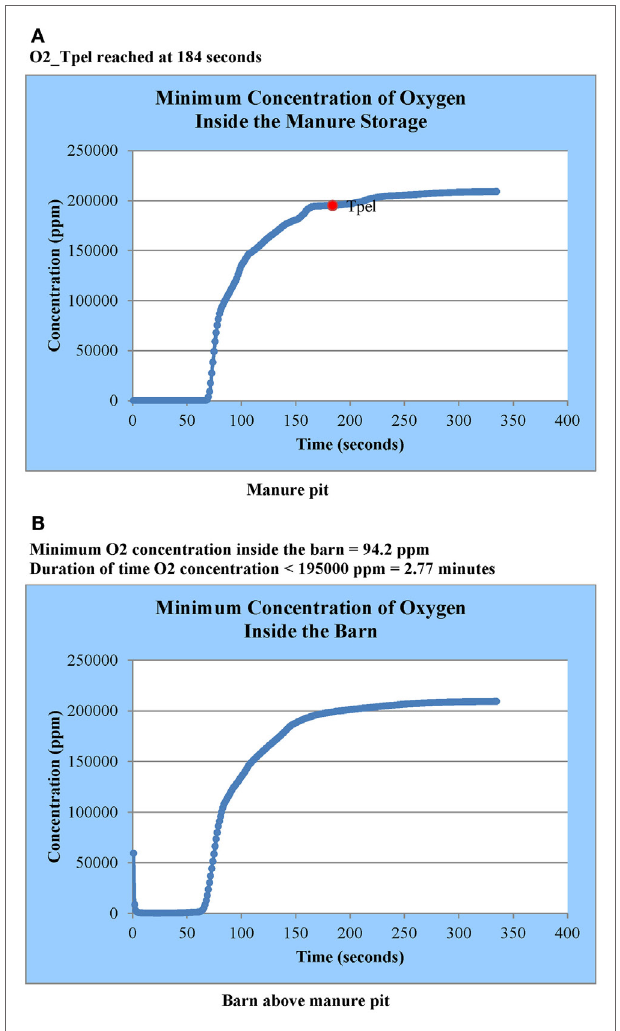
FIgURe 10 | oxygen replenishment curves in (A) manure pit and (B) barn above the manure pit for case Study 1: slotted-covered manure pit beneath a tunnel-ventilated (parallel flow) barn